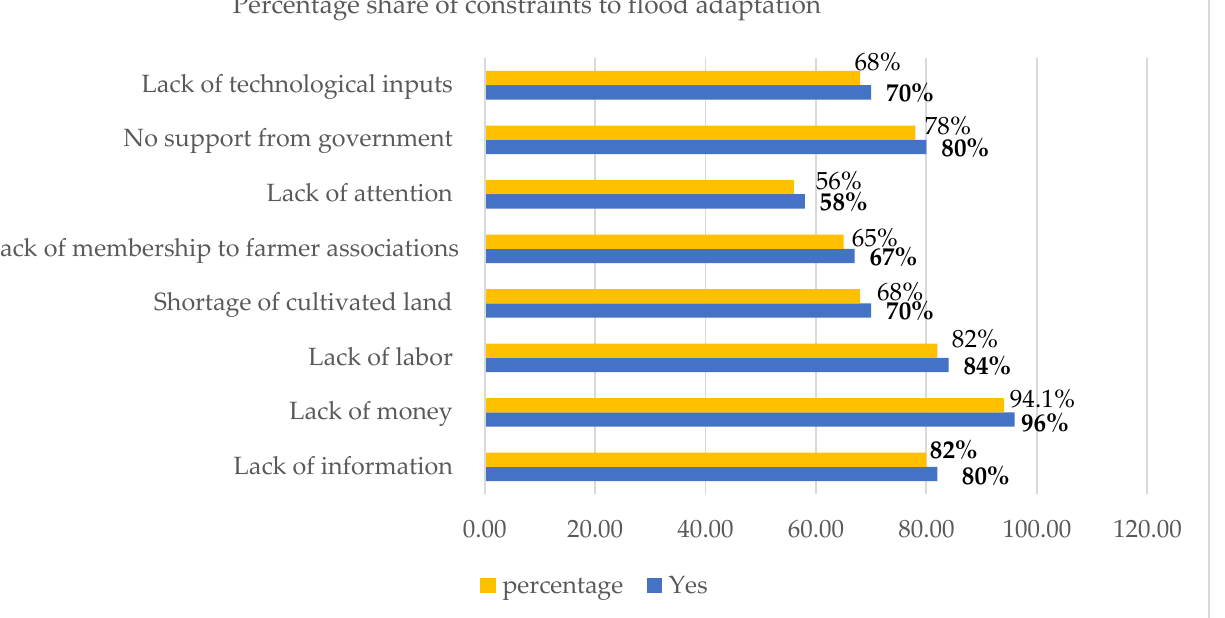
Figure 4. Major Constraints to Flood Adaptation in the Study Area. Source: Household Survey, May 2022.